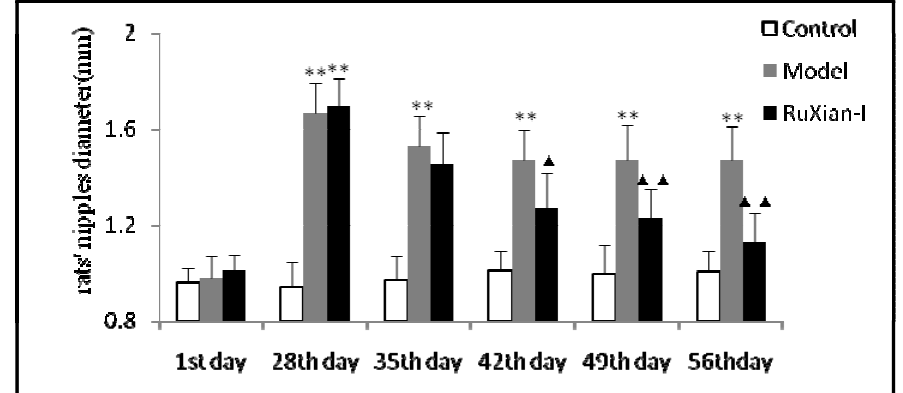
Figure 2. Comparison of nipples diameter in rats. The nipple diameters of the model group were larger than those of the normal controls, and the nipple diameters of the RuXian-I- treated were reduced significantly when compared to the model